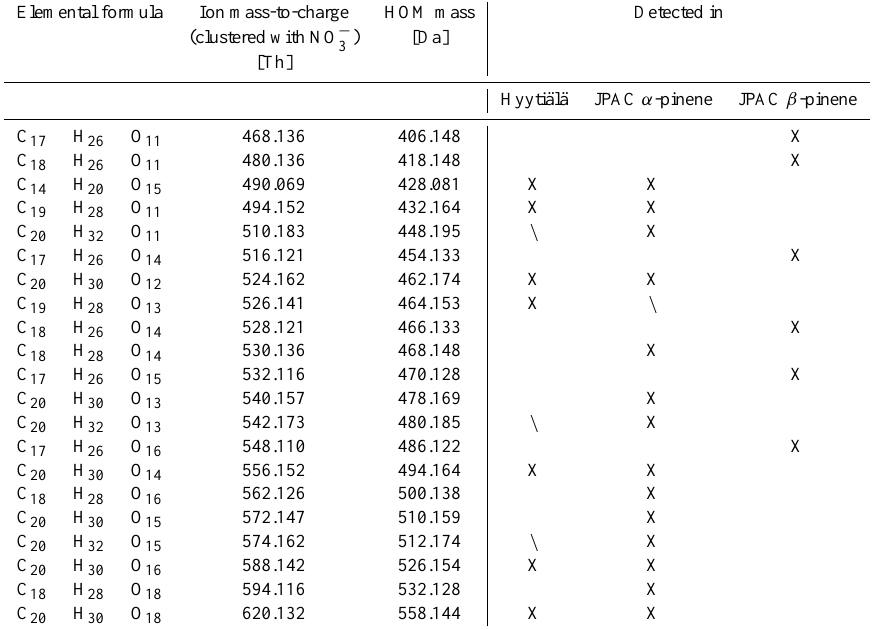
Table A2. List of observed dimers detected in Hyyit¨al¨a and JPAC. An “X” means that the identification is fairly unambiguous, a blank means that the ion has not been detected, and “/” means that the ion might be present, but could not be identified due to insufficient signal or overlapping peaks from other